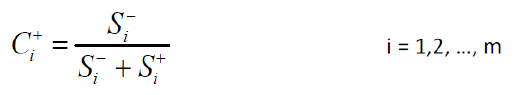
Step 6: Calculation of ideal approximation of solution Ideal and negative ideal separation measures